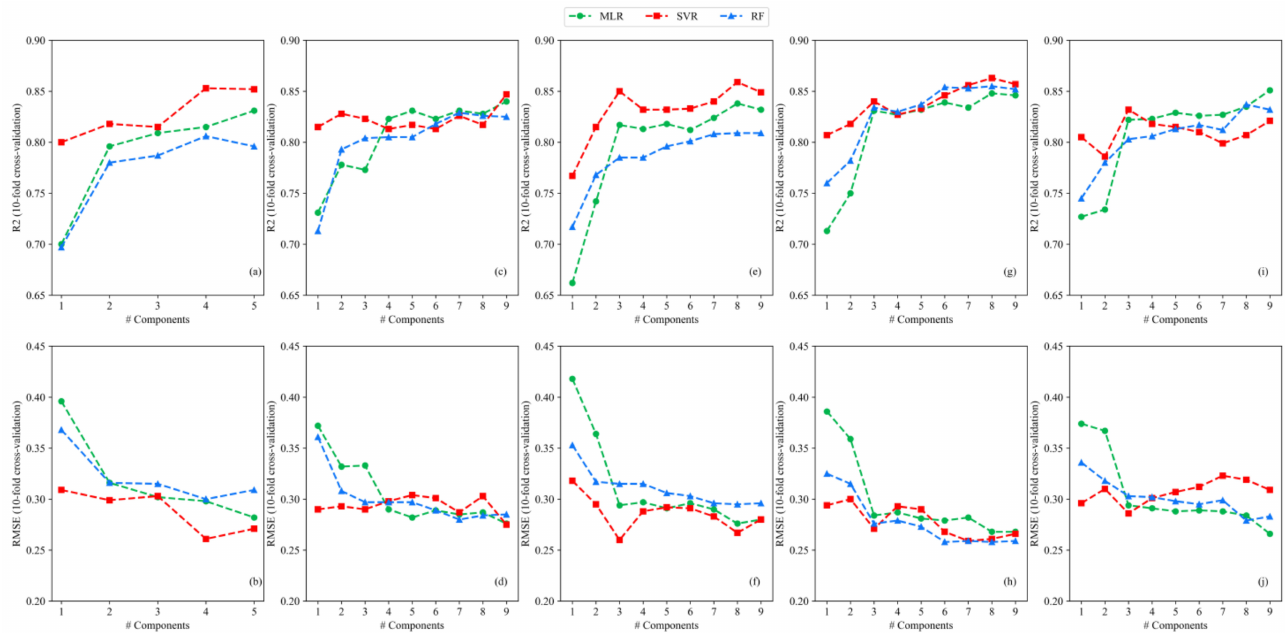
Figure 5. Ten-fold cross-validated R 2 and RMSE values under different PCA components with input sets of VIs ( a , b ), combined VIs and GLCM-based texture features ( c , d ), combined VIs and NDTIs ( e , f ), combined VIs and DTIs ( g , h ), and combined VIs and RTIs ( i , j